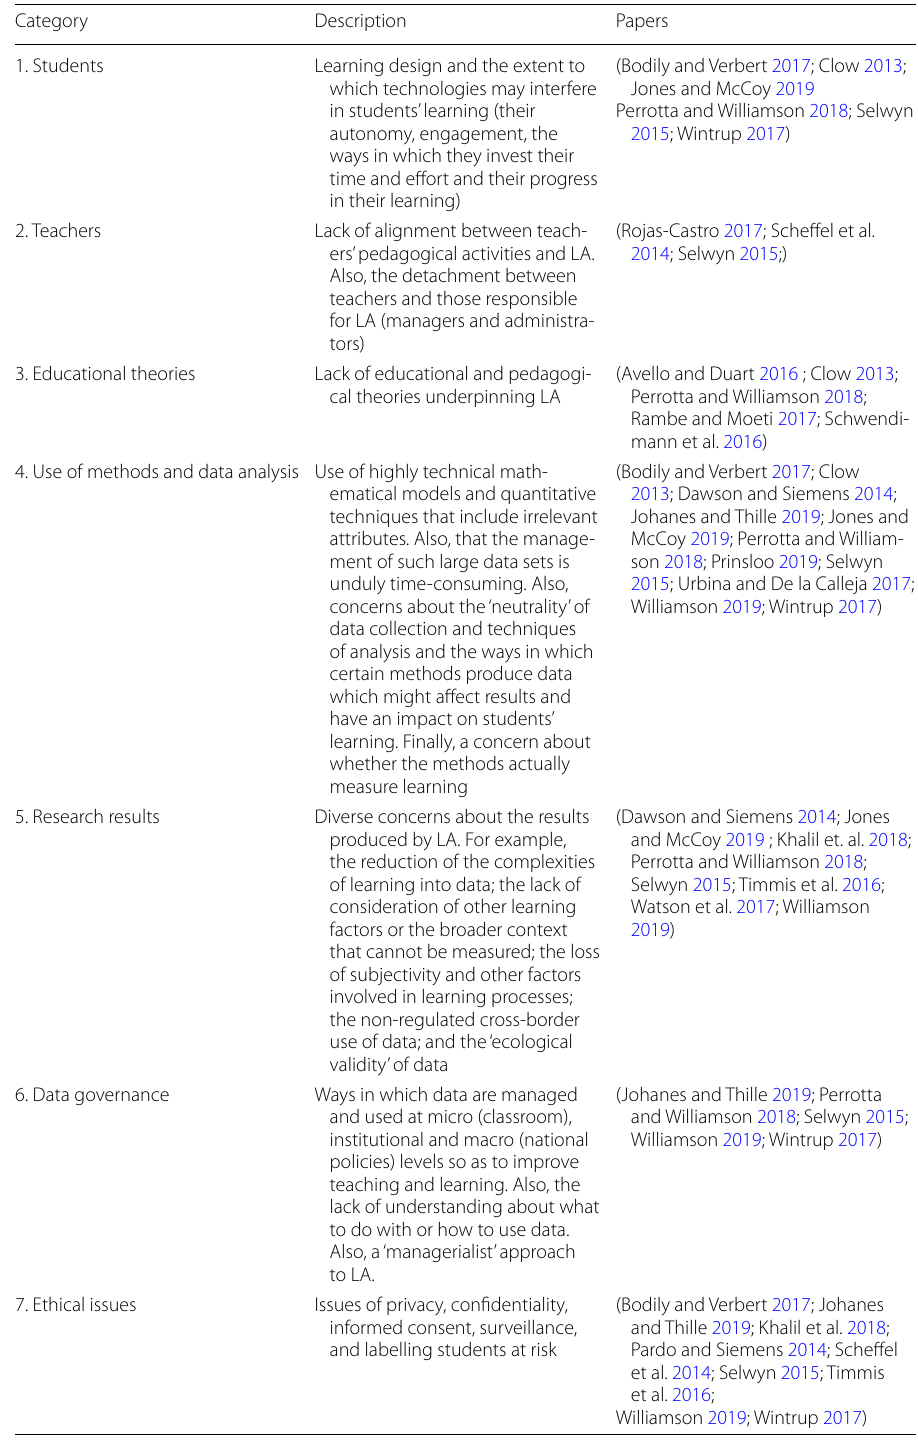
Table 4 Critical issues and challenges for learning